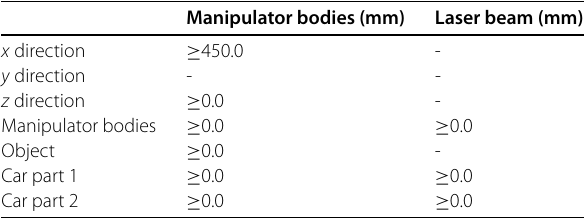
Table 5 Values of the constraints to avoid collisions between manipulator bodies, laser beam and object bodies